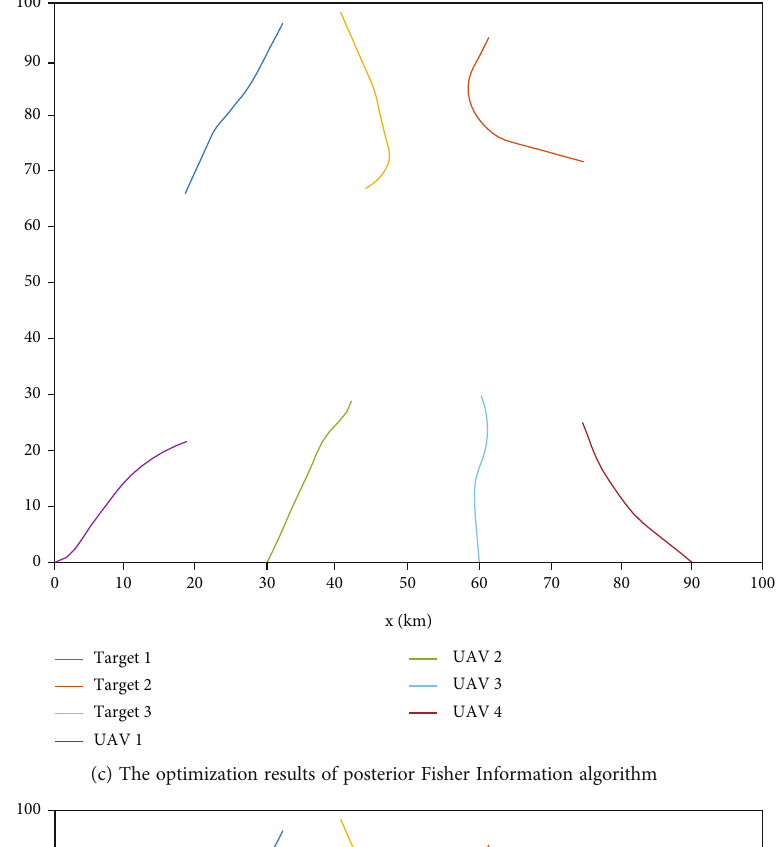
(c) The optimization results of posterior Fisher Information algorithm